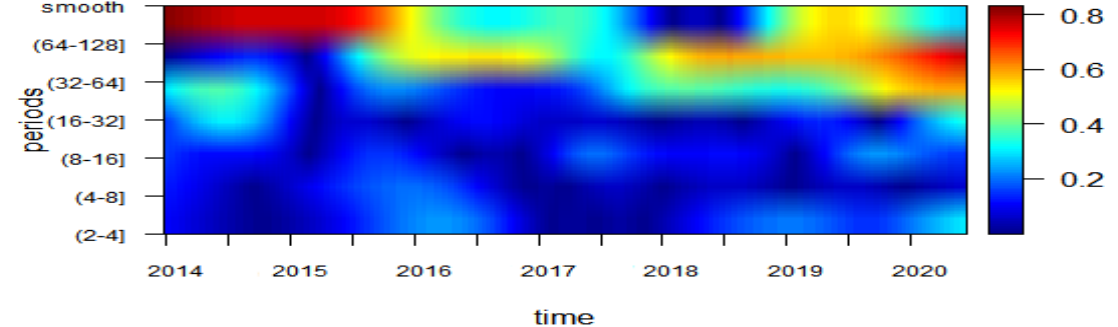
J. Risk Financial Manag. 2021 , 14 , x FOR PEER REVIEW 12 of 19